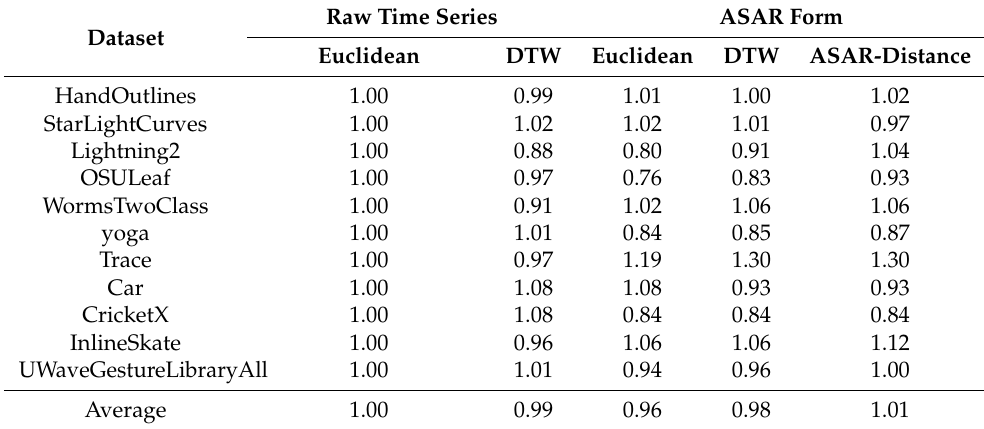
Table 2. F-measure relative results for 1-NN classification.